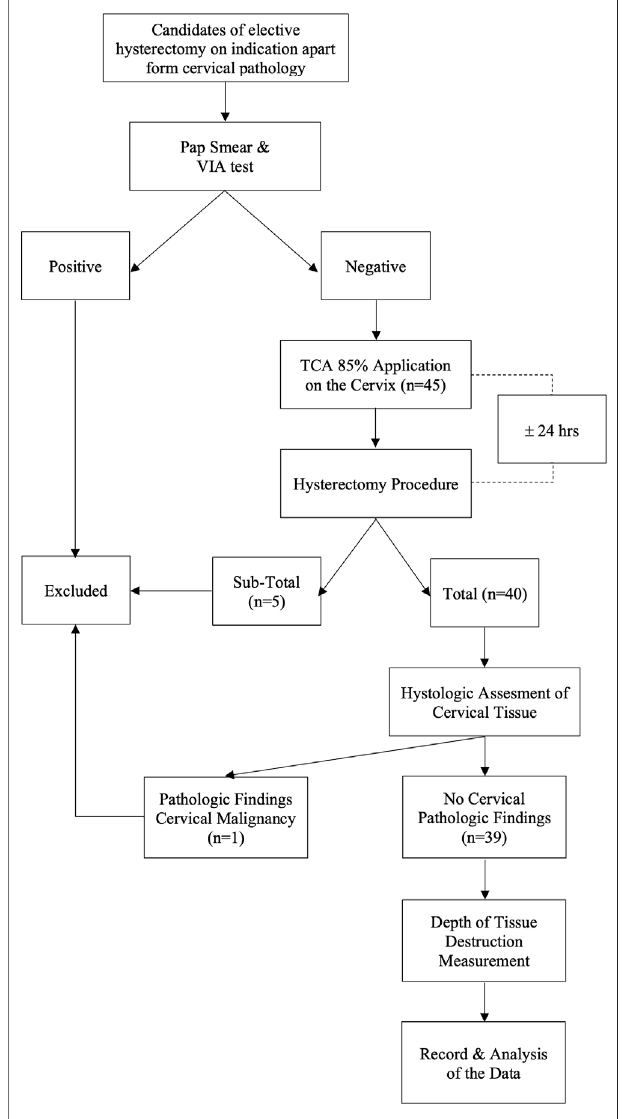
FIGURE 1 | Flow chart of the